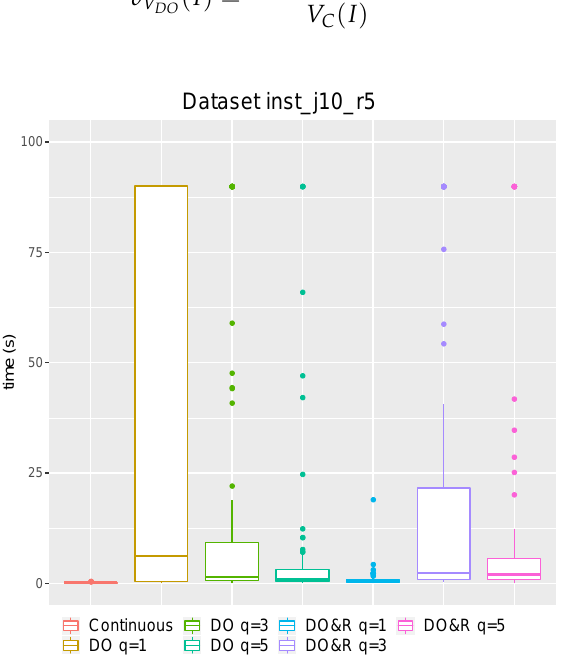
Figure 4. Time boxplot for different cases of discrete objective and allocation for dataset inst _ j 10_ r 5. Table 10. Mean values for different